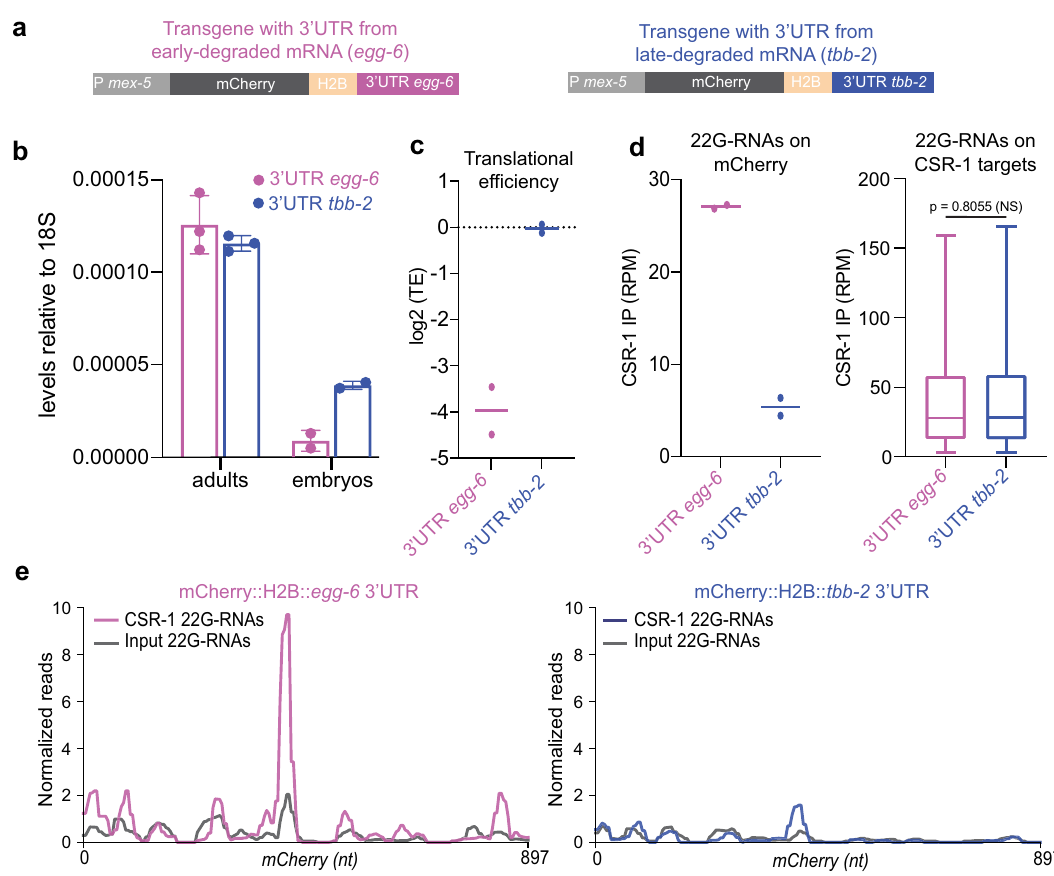
Fig. 6 Ribosome occupancy affects CSR-1-mediated maternal mRNA clearance. a Schematic of the germline-expressed single-copy mCherry::h2b transgenic mRNA fused to a 3 ′ UTR derived from an early- ( egg-6 3 ′ UTR ) or a late-degraded ( tbb-2 3 ′ UTR ) mRNAs. b RT-qPCR assay to detect the levels of mCherry mRNA from the two transgenic reporters in adults and early embryos. The bars indicate the mean, the error bars the standard deviation, and the black dots individual data from three or two biologically independent replicates in adults and embryos respectively. The levels of mCherry mRNA are normalized on the levels of ribosomal 18S RNA. c Translational ef fi ciency (TE) of mCherry::h2b transgenic mRNAs. The lines indicate the mean and the dots individual data from two biologically independent experiments. d Abundance of CSR-1-bound 22G-RNAs antisense to mCherry (left) or the coding sequence of embryonic CSR-1 targets (right). The lines indicate the mean and the dots individual data from two biologically independent experiments (left). For the box plots (right), the line indicates the median value, the box indicates the fi rst and third quartiles, and the whiskers indicate the 5th and 95th percentiles, excluding outliers. Two-tailed P value were calculated using the Mann – Whitney – Wilcoxon test. Sample size n = 2351 (CSR-1 mRNA targets). e Metapro fi le analysis showing normalized 22G-RNA reads (RPM) across mCherry nucleotide sequence from mCherry::h2b transgenic mRNA fused to egg-6 3 ′ UTR (left) or tbb-2 3 ′ UTR (right) in CSR-1 immunoprecipitation (IP) or total RNA input. The average from two biologically independent replicates is shown. Source data are available